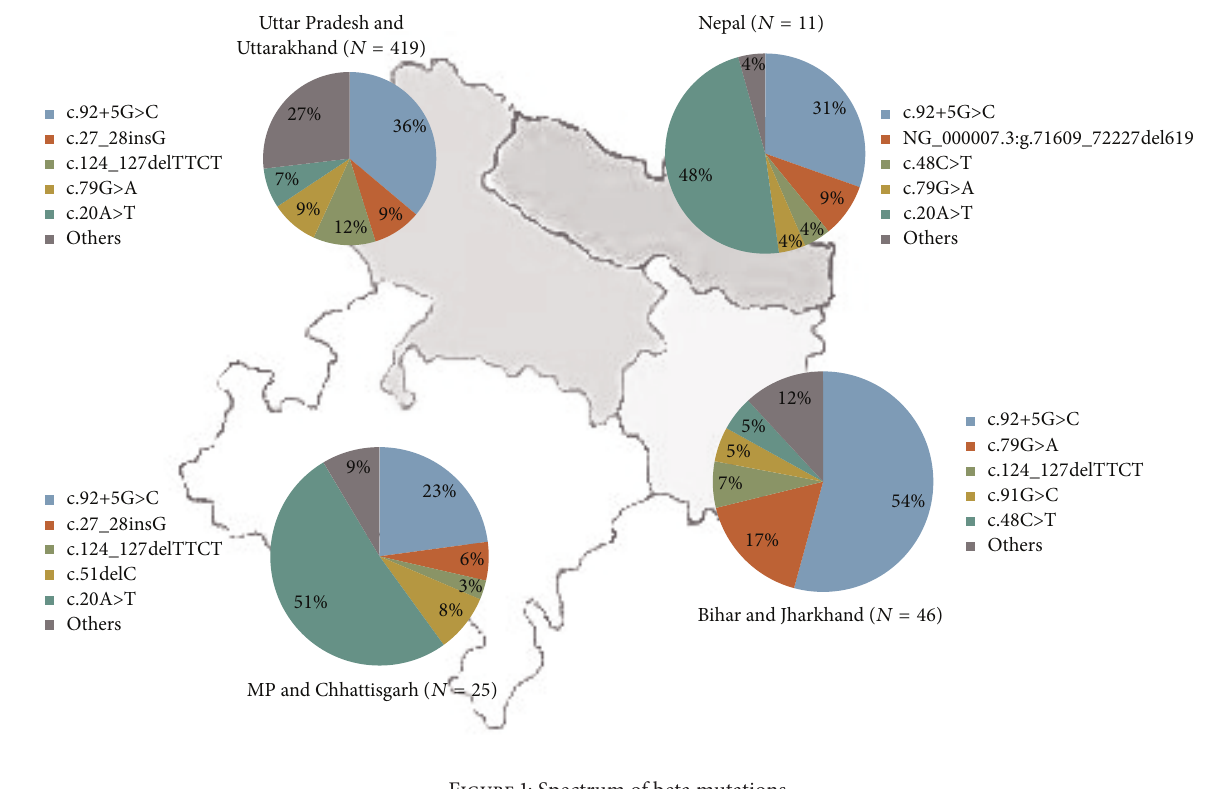
Figure 1: Spectrum of beta mutations. Table 2: Status of the 𝛽 mutation in consanguineous and nonconsanguineous group. Mutations